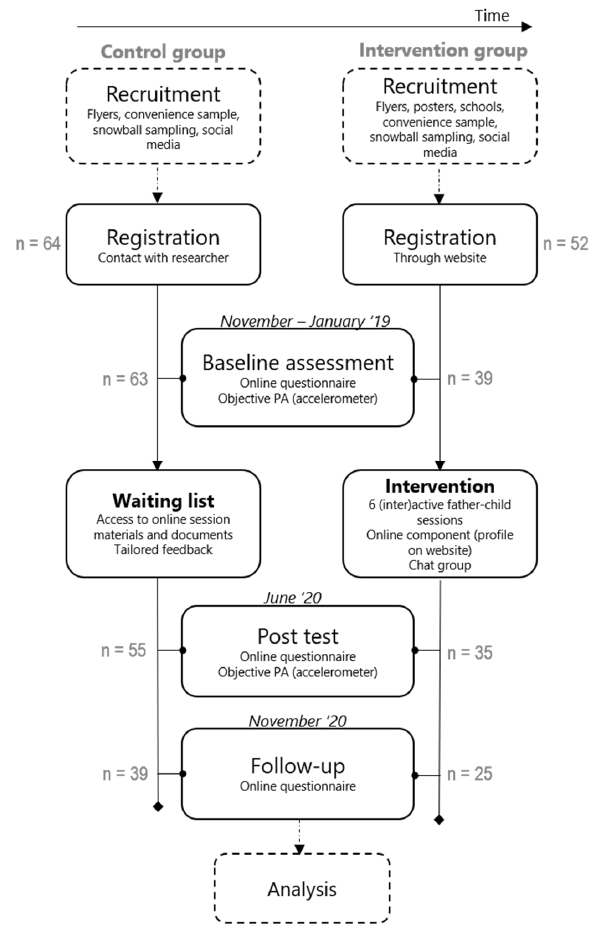
Figure 4. Study design and flow of the Run Daddy Run intervention.